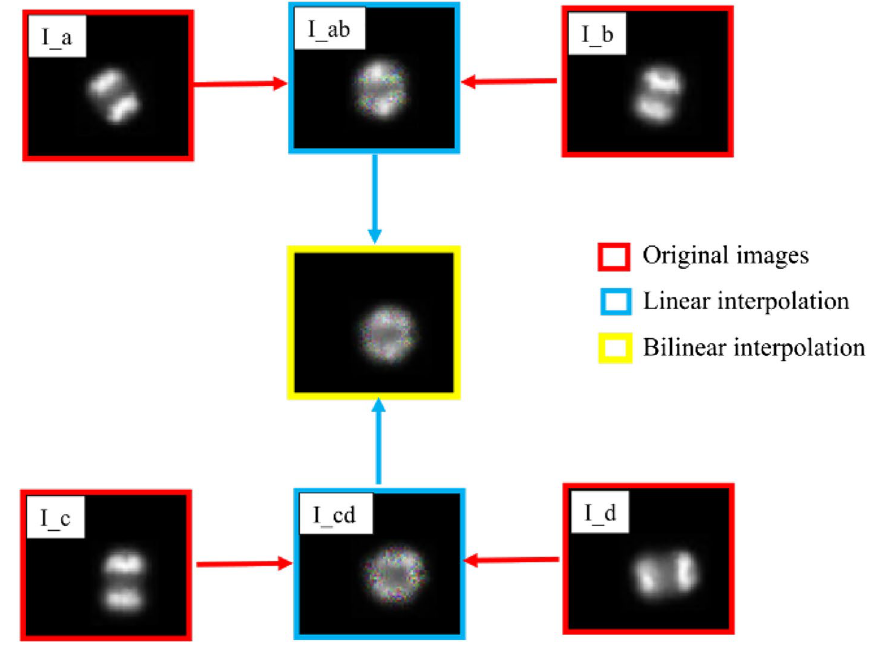
Figure 6. mixup using bilinear